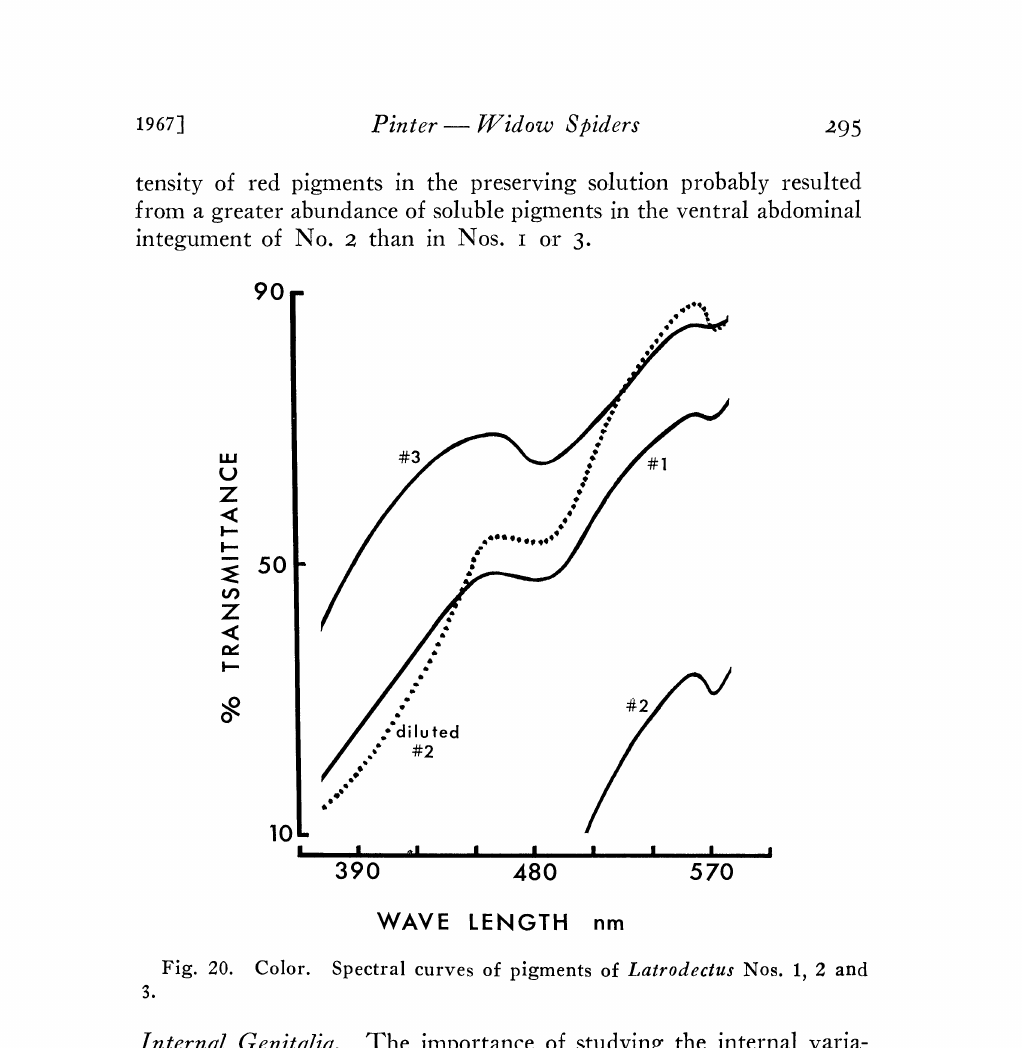
Fig. 20. Color. Spectral curves of pigments of Latrodectus Nos. 1, 2 and 3. Internal